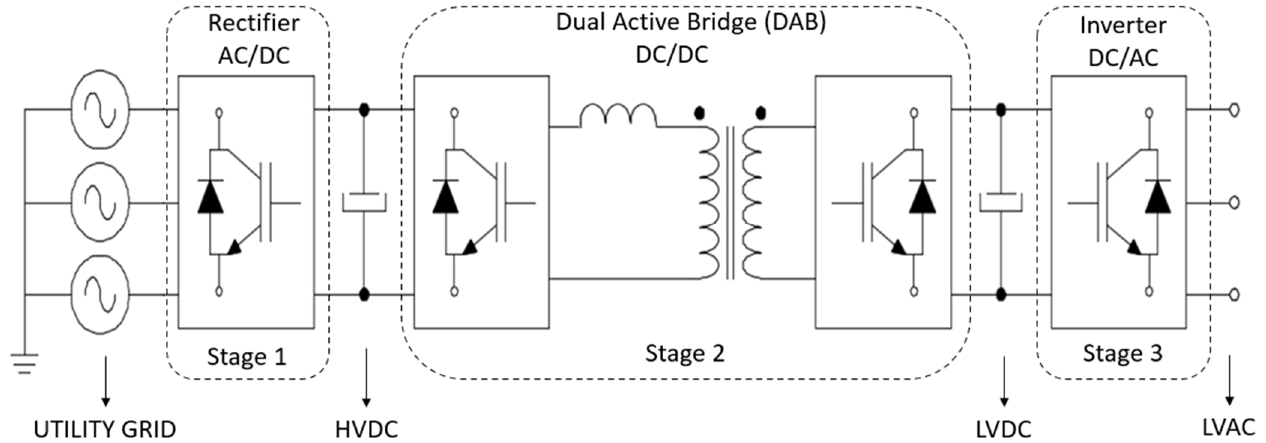
Figure 1. Solid-state transformer with highlighted DC-DC